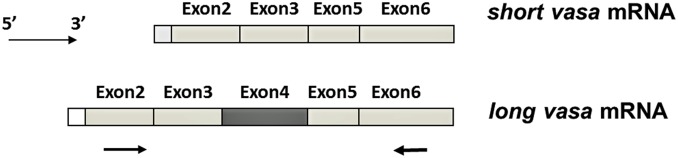
Two vasa splicing variants in zebrafish (Krøvel et al., 2004).Male zebrafish have short vasa mRNA and female zebrafish have both short and long vasa mRNA. A pair of primers was designed crossing exon 2 and exon 6 (arrow). The sequences of primers are: vasa_long_forward 5′-CCCAATATGGATGACTGGGAG-3′; vasa_long_reverse 5′-CAGCACCTCCTGTATAAAAGC-3′. A PCR method was applied to distinguish male and female based on the numbers of bands of PCR products on the gel. Female fish have two bands and male fish have one band. In addition, expression of exon 4 within vasa gene was quantified by real-time QPCR. The sequences are: exon4_forward: 5′-CTTCACGCGTGTCCACCTG-3′; exon4_reverse: 5′-GCTCTTGAATCCTCCATCAGAACC-3′.